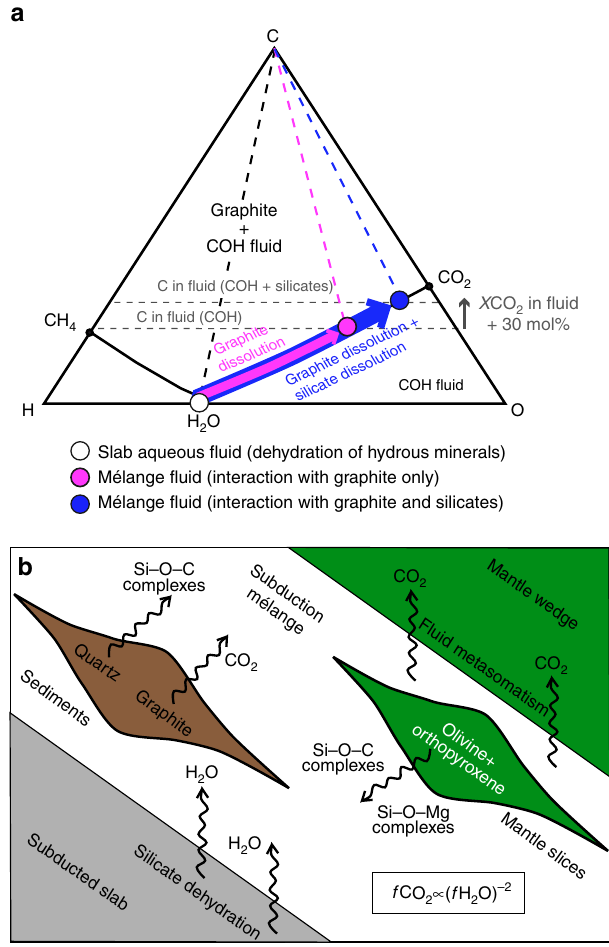
Fig. 4 Evolution of dissolved CO 2 in fl uids fl ushing a subduction mélange. a C – O – H diagram showing the compositional evolution of an aqueous fl uid ( empty dot ) from a slab interacting with graphite alone ( magenta dot ) and graphite + silicates ( blue dot ) in the subduction mélange. Compared to fl uids interacting with graphite alone, fl uids in equilibrium with graphite + silicates display markedly higher X CO 2 (up to + 30 mol% at 1 GPa, 800 °C and f H 2 FMQ ); b schematic drawing of a subduction mélange typical